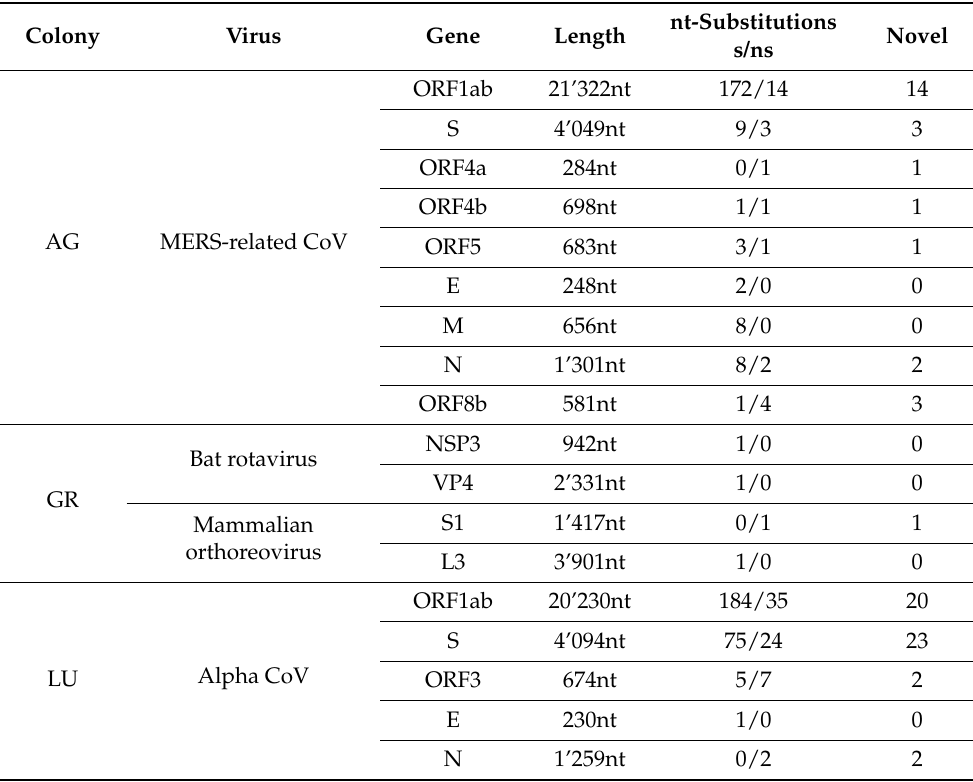
Table 2. SNVs detected in selected RNA viruses found in the bat colonies. Genes are shown with the length and the number of synonymous (s)/non-synonymous (ns) nucleotide (nt) and novel substitutions. Colony Virus Gene Length